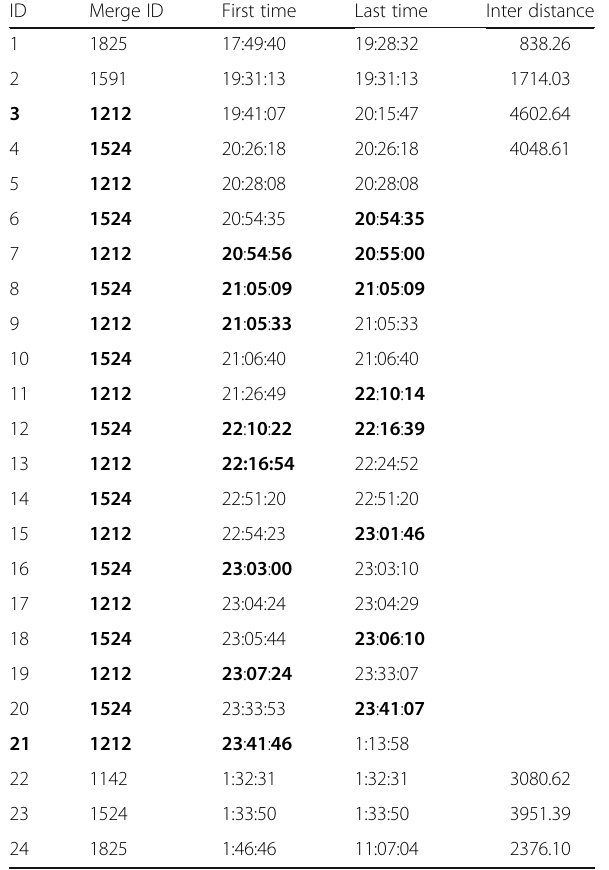
Table 5 Records of one user trajectory